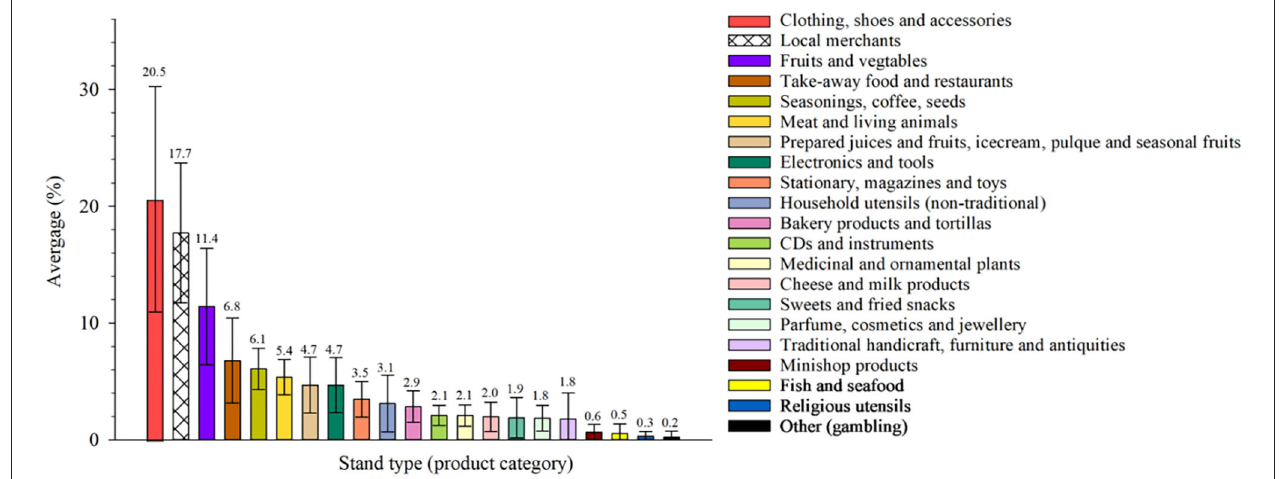
FIGURE 3 | Mean of the proportion (%) of stand types in 10 rural markets in the Huasteca